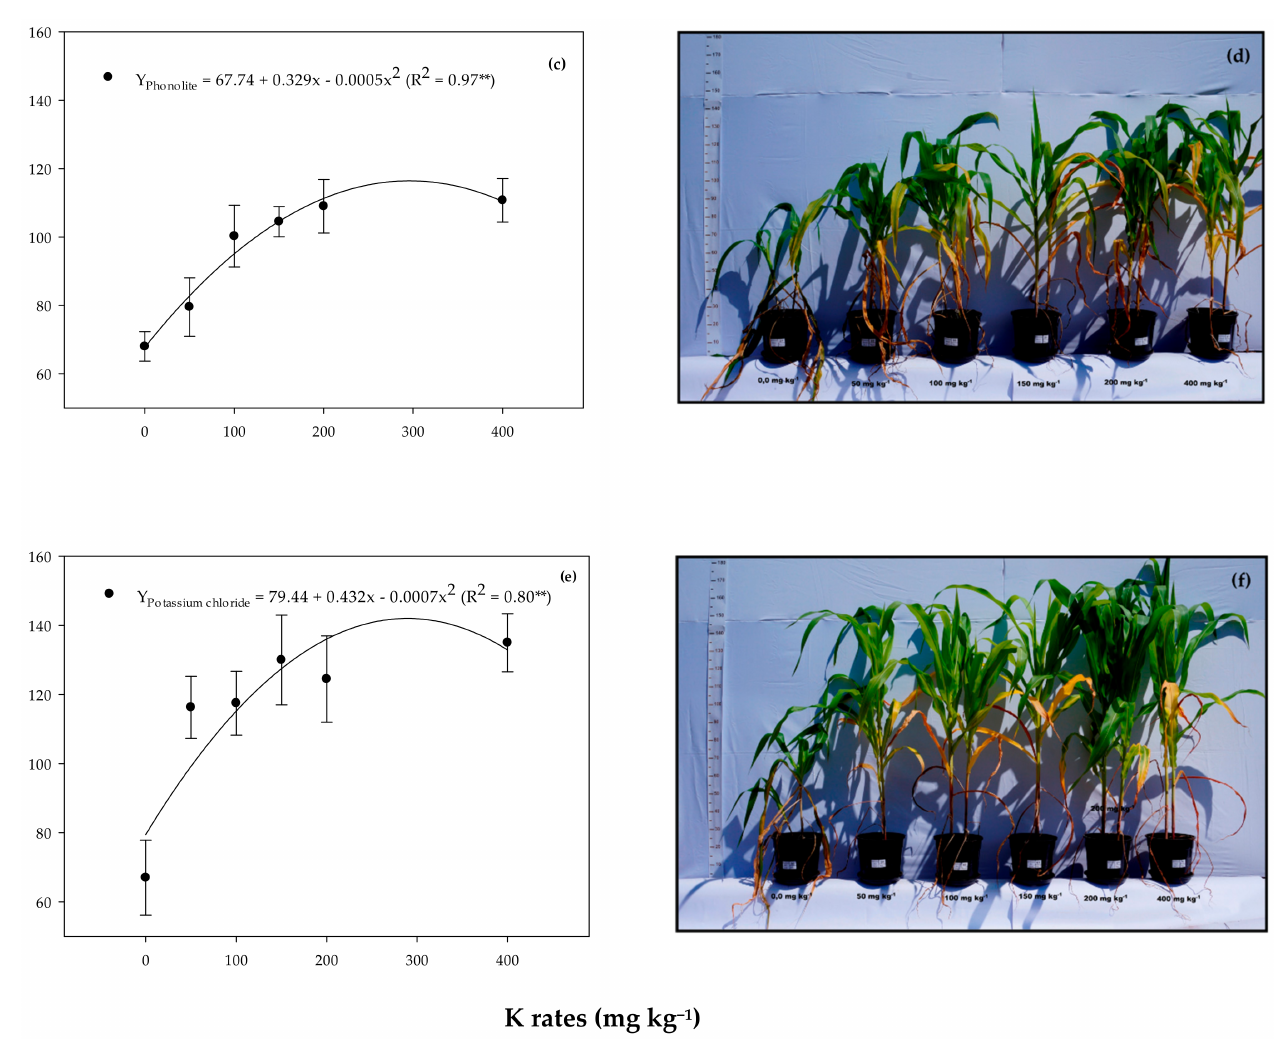
Figure 2. Plant height and comparative growth 45 days after the emergence of maize grown in the Typic Quartzipsamment with increasing rates of K via nepheline syenite ( a , b ), phonolite ( c , d ), and potassium chloride ( e , f ). **—Significant at the p < 0.01 level. Bars represent the standard error of the